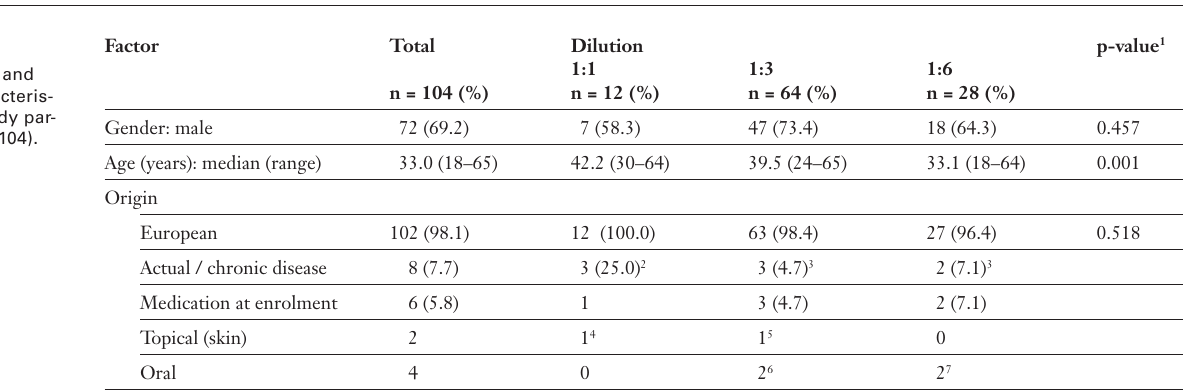
Demographic and medical characteris- tics of the study par- ticipants (n =